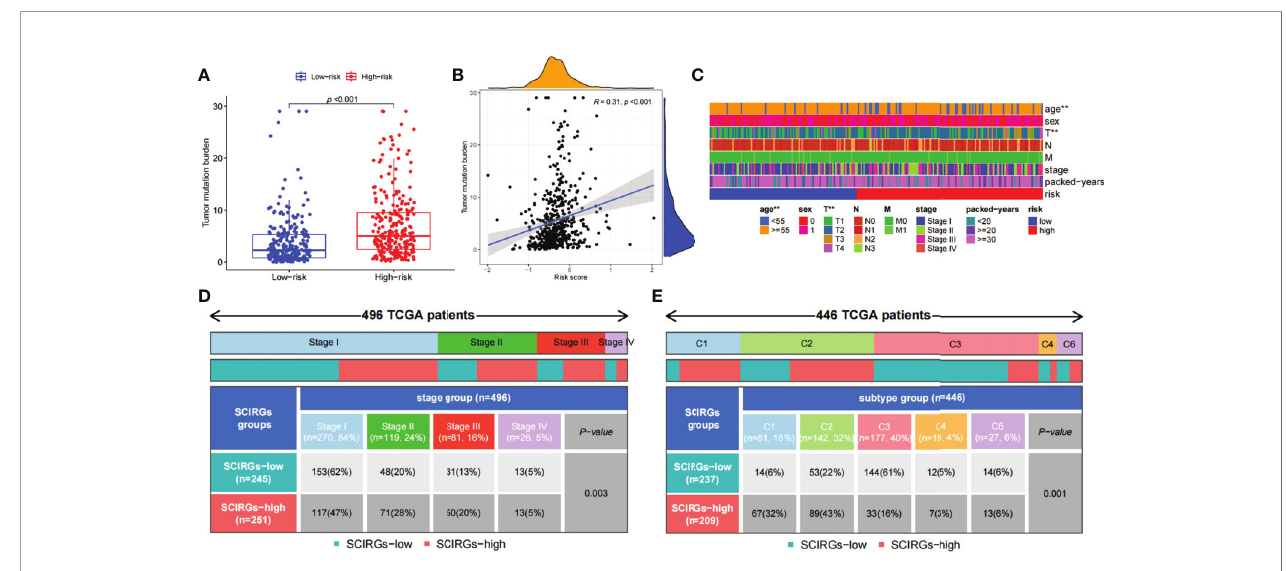
FIGURE 8 | (A) The difference of TMB between the high- and low-risk groups. (B) Association between TMB and risk score. (C) The proportion of clinical characteristics of every sample in relative risk group was presented in heat map. (D) Proportion of patients in different stages of high- and low-risk groups. (E) Proportion of patients in different immune sub-typing of high- and low-risk groups. *p < 0.05, **p < 0.01, ***p <